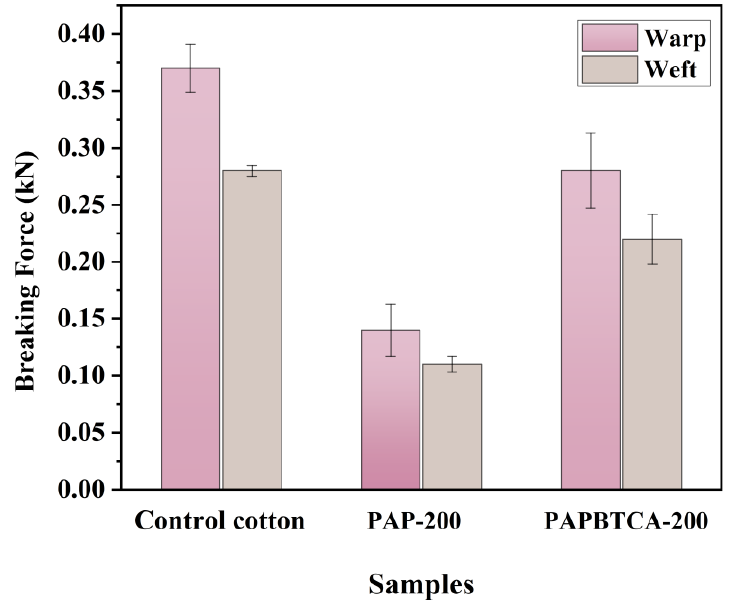
Figure 10. Breaking force of the control, PAP-200, and PAPBTCA-200.